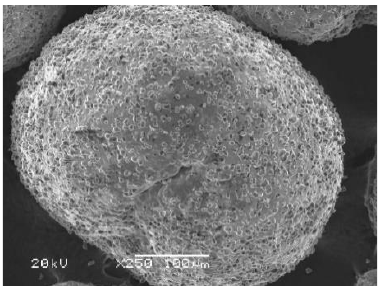
Figure 5. The surface topography of magnetic abrasive. Table 1. Mechanical properties of TC4. Table 2. Machining